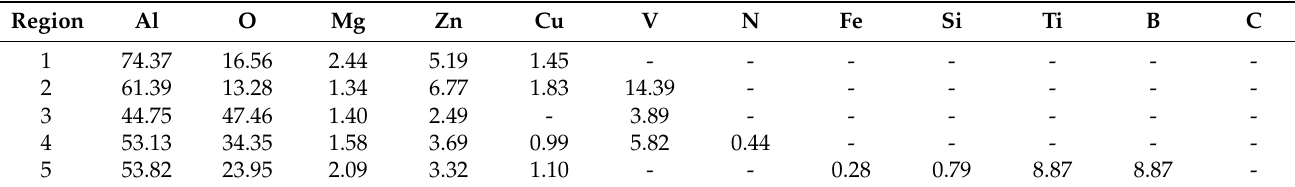
Figure 7. Worn surface analysis of samples after wear test at 100 ◦ C. ( a1 ) worn surface of Al 7075; ( a2 ) 3D laser scanning topography of Al 7075; ( b1 ) worn surface of 15 wt.% VN/7075; ( b2 ) 3D laser scanning topography of 15 wt.% VN/7075; ( c1 ) worn surface of 20 wt.% TiB 2 -TiC x /7075; ( c2 ) 3D laser scanning topography of 20 wt.% TiB 2 -TiC x /7075. Table 4. EDS results (wt.%) in regions 1–5 indicated in Figure